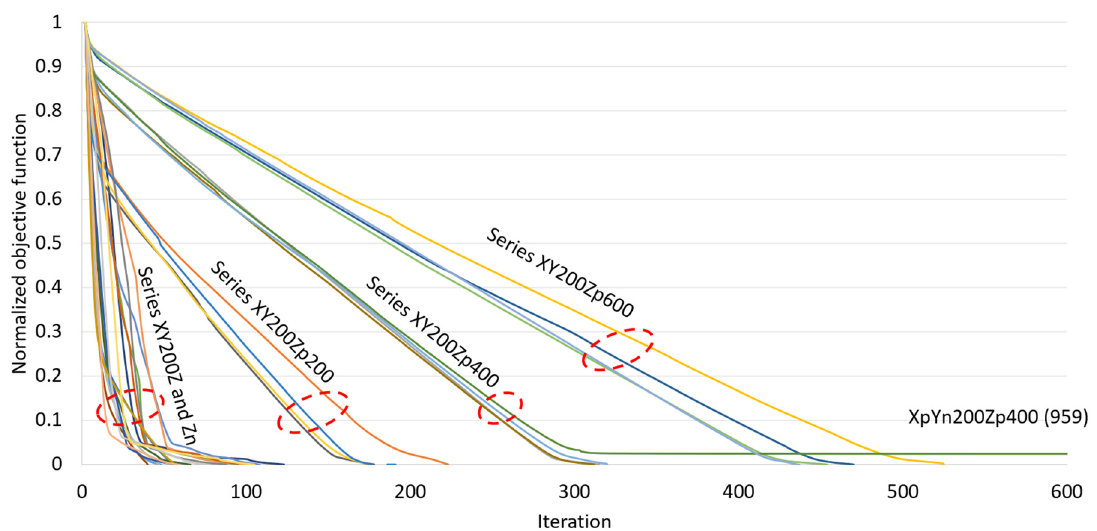
Figure 13. Convergence history for 28 shape change analysis cases in the tri ‐ directional mode for series XY200 for SB2.